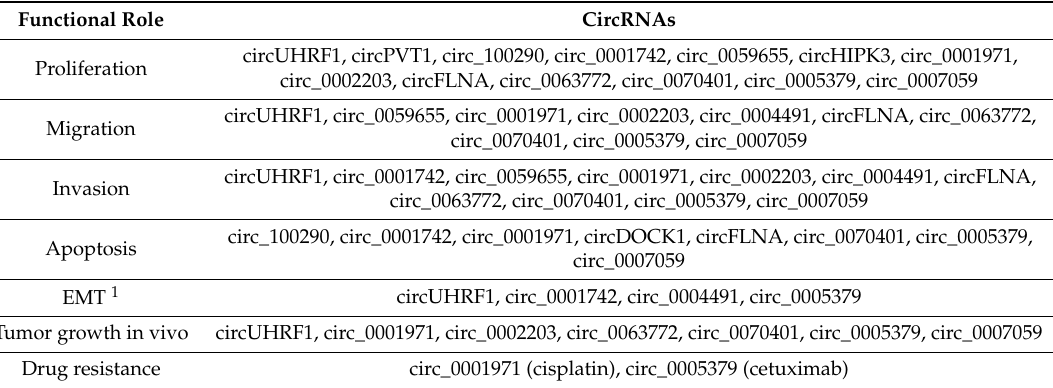
Table 2. CircRNAs as regulators of key cellular properties in oral